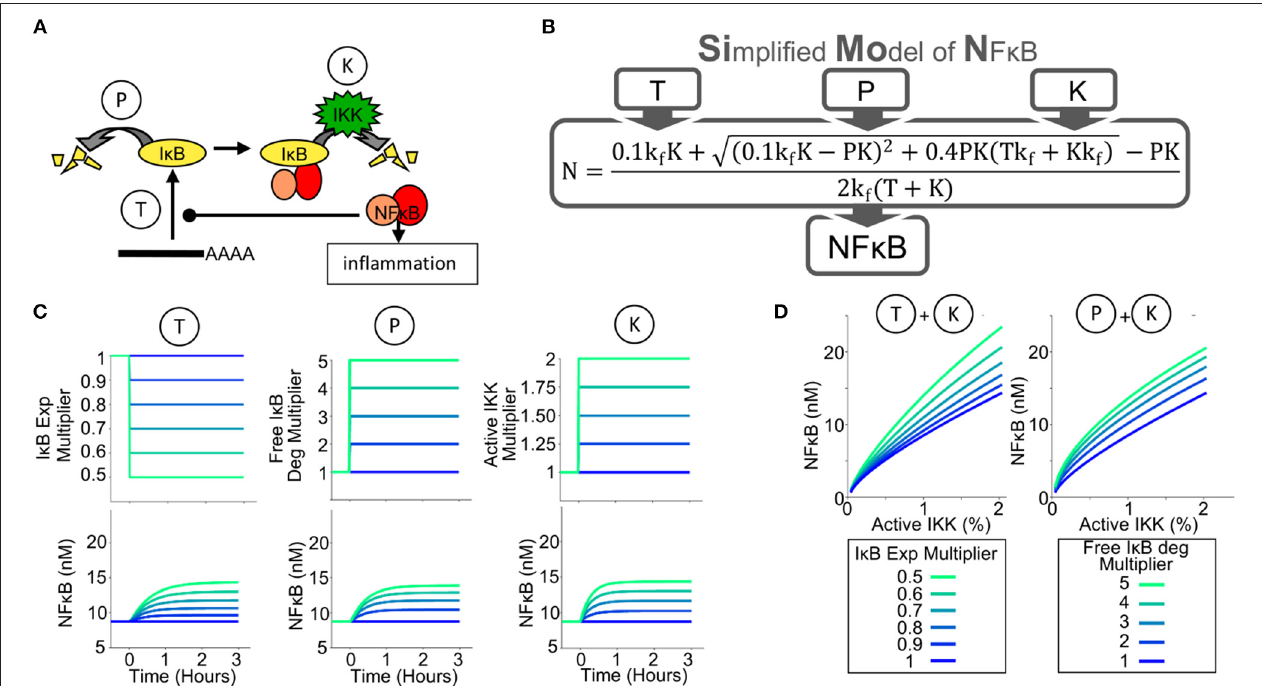
FIGURE 1 | A Simplified Model of NF κ B Activity (SiMoN) can predict NF κ B activity from 3 parameters. (A) Schematic of the key reactions controlling NF κ B activity through I κ B metabolism. The amount of free, transcriptionally active, NF κ B (NF κ B activity) is tightly controlled by the amount of I κ B; therefore I κ B synthesis (reaction T) and free I κ B degradation (reaction P) may potentially offer alternative points of control. The primary, canonical activation pathway is through IKK (reaction K), however, interferons do not directly activate IKK. (B) Schematic of the Simplified Model of NF κ B (SiMoN), which analytically calculates NF κ B as a result of parameters T,P and K. (C) Modeled time-course concentrations of free NF κ B (lower), in response to perturbed reaction rates obtained by multiplying the WT parameter value by the multiplier indicated (upper) utilizing the simplified model. (D) Steady-state free NF κ B concentrations in response to: increased IKK activity and I κ B translation inhibition (left) and increased IKK activity and free I κ B degradation